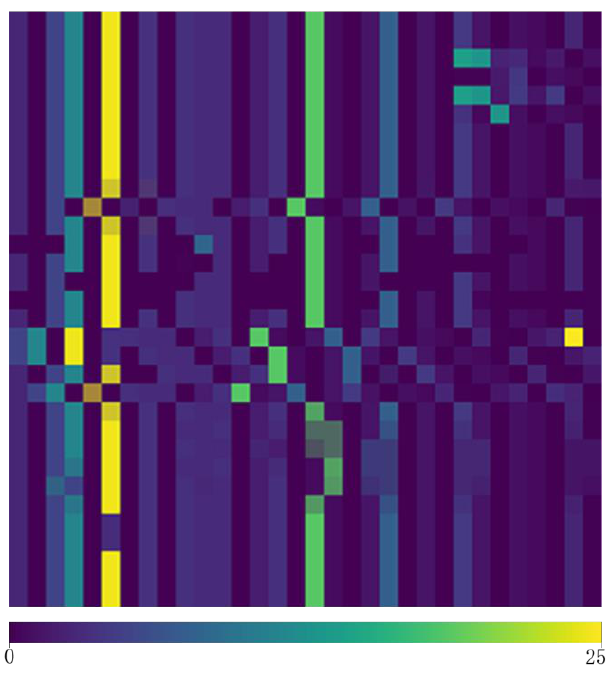
Figure 4. Final effect diagram after processing input samples.